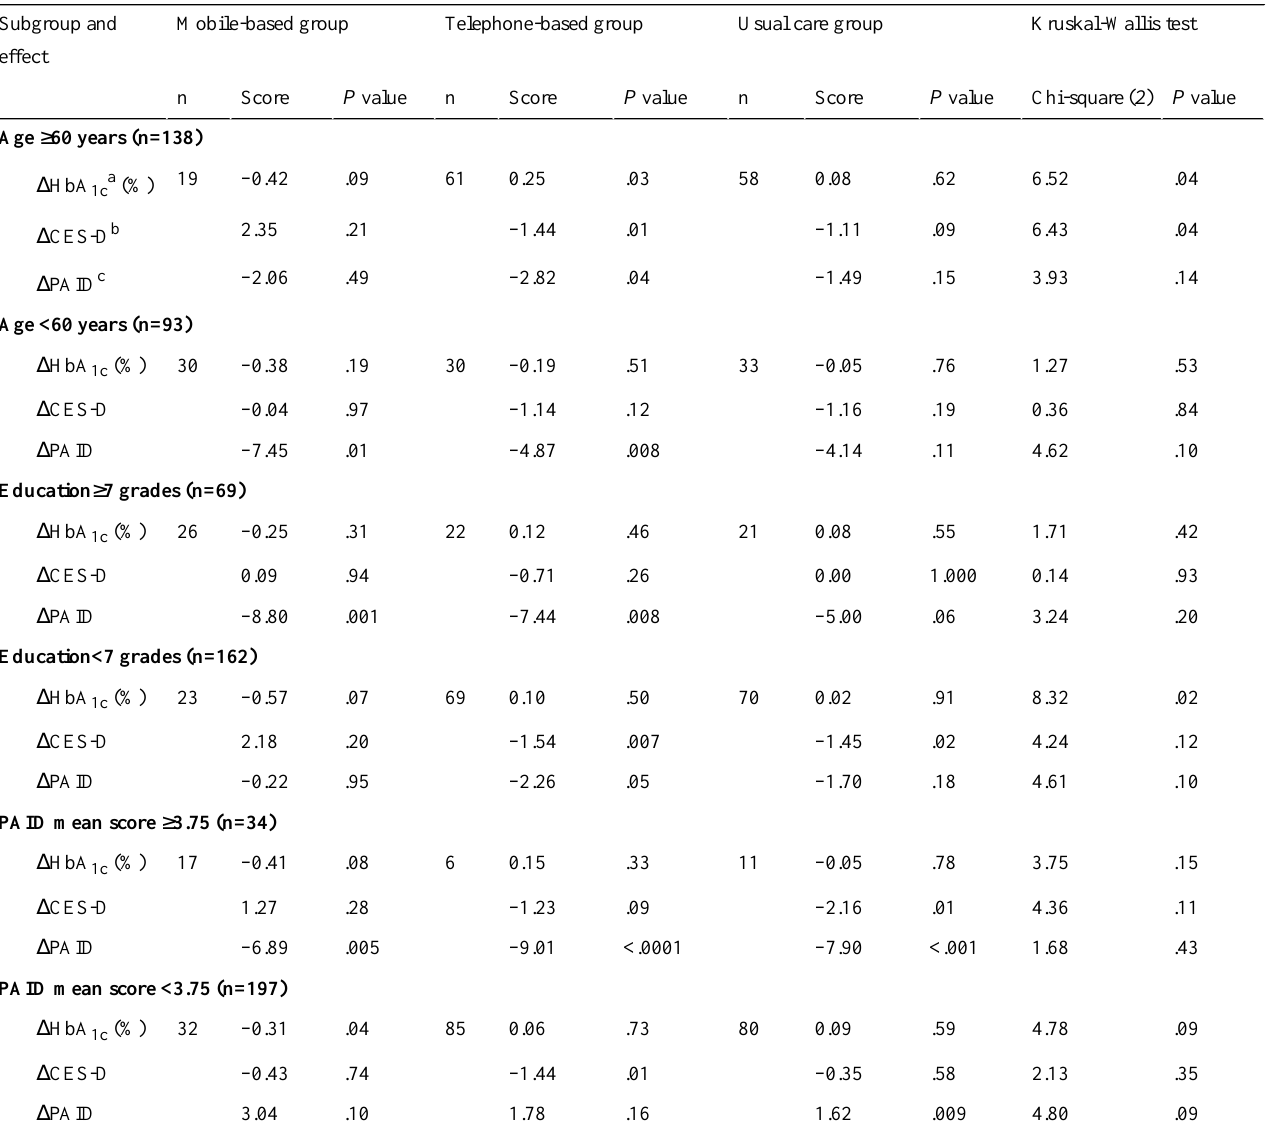
Table 3. Sensitivity analysis comparing the intervention effects in the different